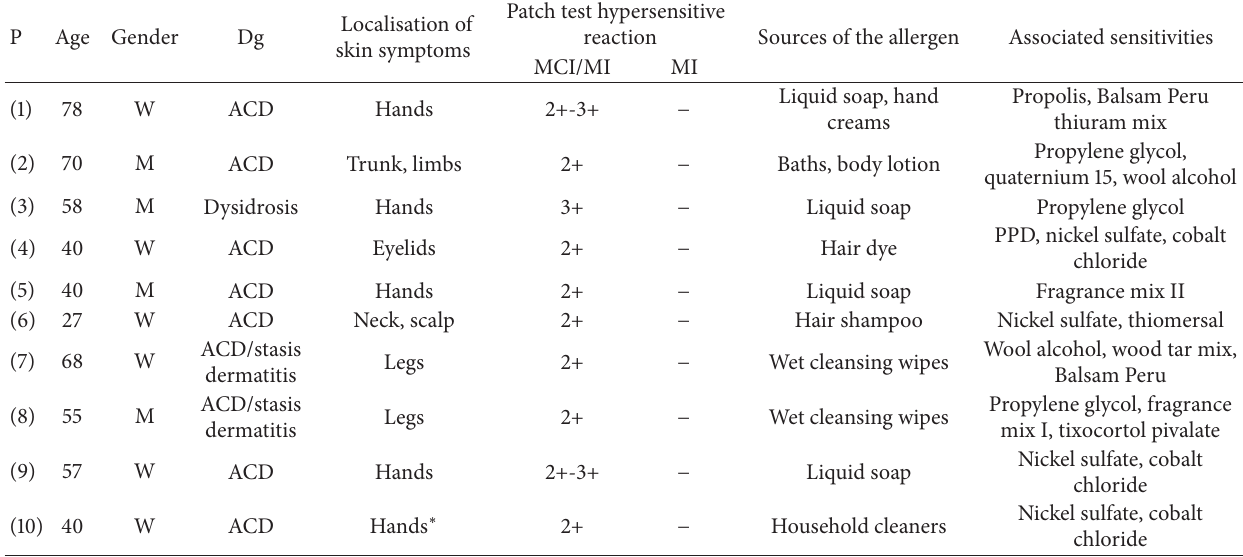
Table 2: Localisation of clinical symptoms and associated sensitivities of MCI/MI and/or MI hypersensitive patients (total tested patients, 𝑛 = 314 ). (a) MCI/MI hypersensitive patients: localisation of clinical symptoms and associated sensitivities ( 𝑛 = 10